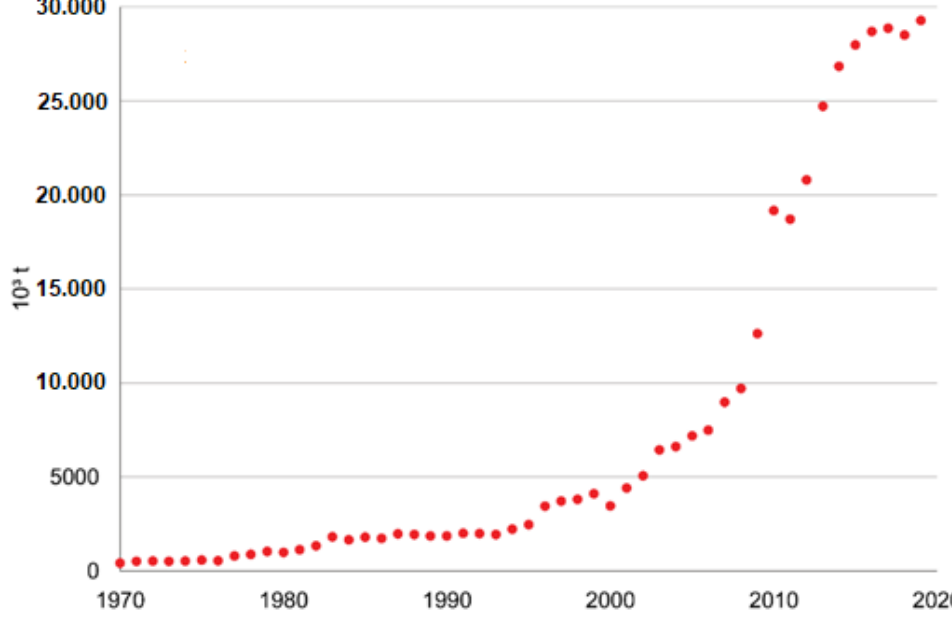
Figure 3. Transformation of sugarcane bagasse in electric energy (1970–2019) in Brazil [170].